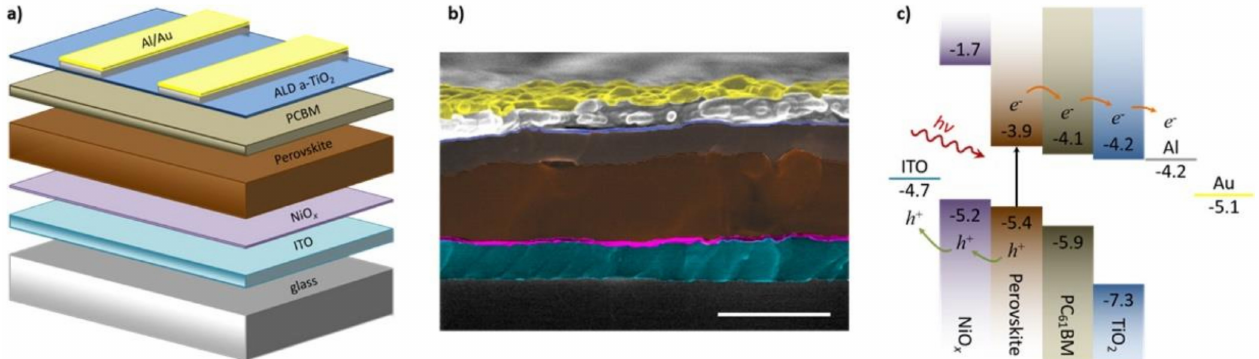
Figure 3. ( a ) Device architecture and ( b ) false color SEM image of the inverted perovskite photovoltaic device (scale bar 500 nm). ( c ) Idealized energy level diagram of the corresponding device architecture. Reproduced with permission from Reference